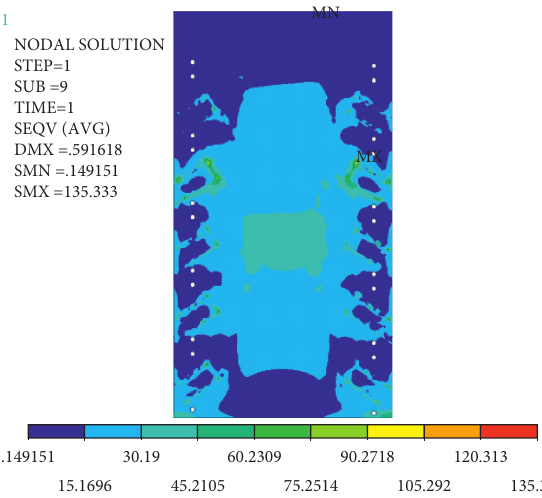
Figure 12: von Mises stress distribution of the side plate